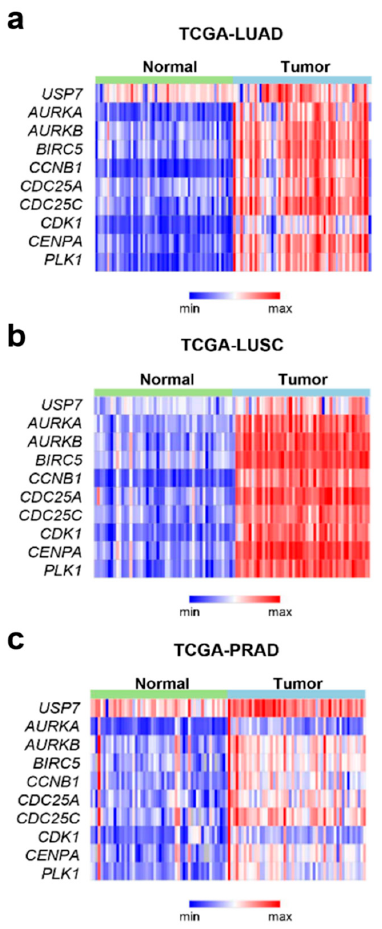
Figure 2. The gene expression profile of USP7 in paired normal and tumor tissues from several types of carcinomas. Heat maps were generated using patient datasets from TCGA of lung adenocarcinoma (TCGA-LUAD) ( a ), lung squamous cell carcinoma (TCGA-LUSC) ( b ) , and prostate adenocarcinoma (TCGA-PRAD) ( c ). Heat maps show the expression profiles of mitotic genes, including USP7 , AURKA, AURKB, BIRC5, CCNB1 , CDC25A, CDC25C, CDK1, CENPA, and PLK1 .